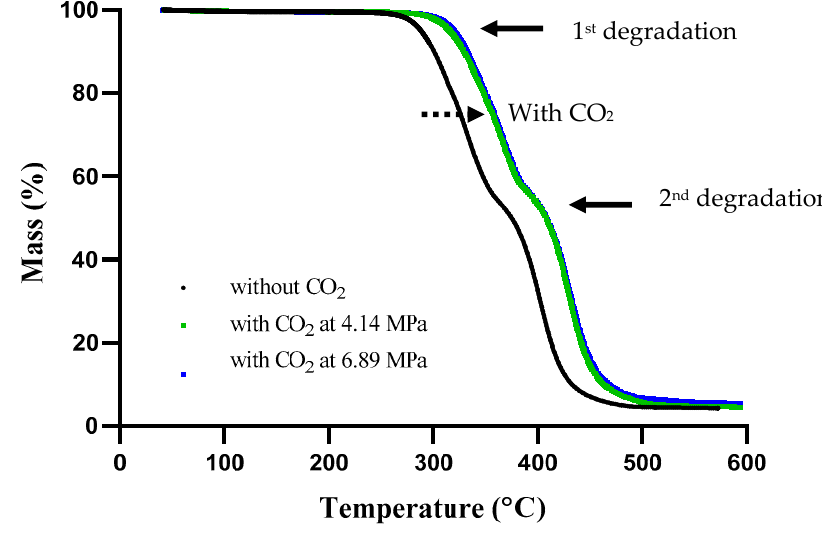
Figure 5. TGA thermogram of Pellethane TPU with and without CO 2 .